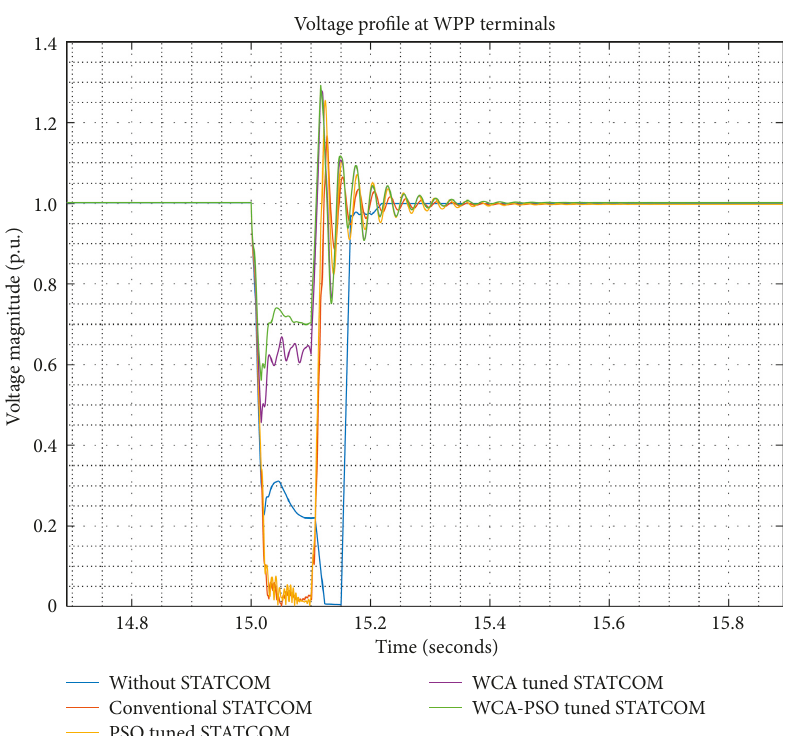
Figure 15: Voltage profile at WPP